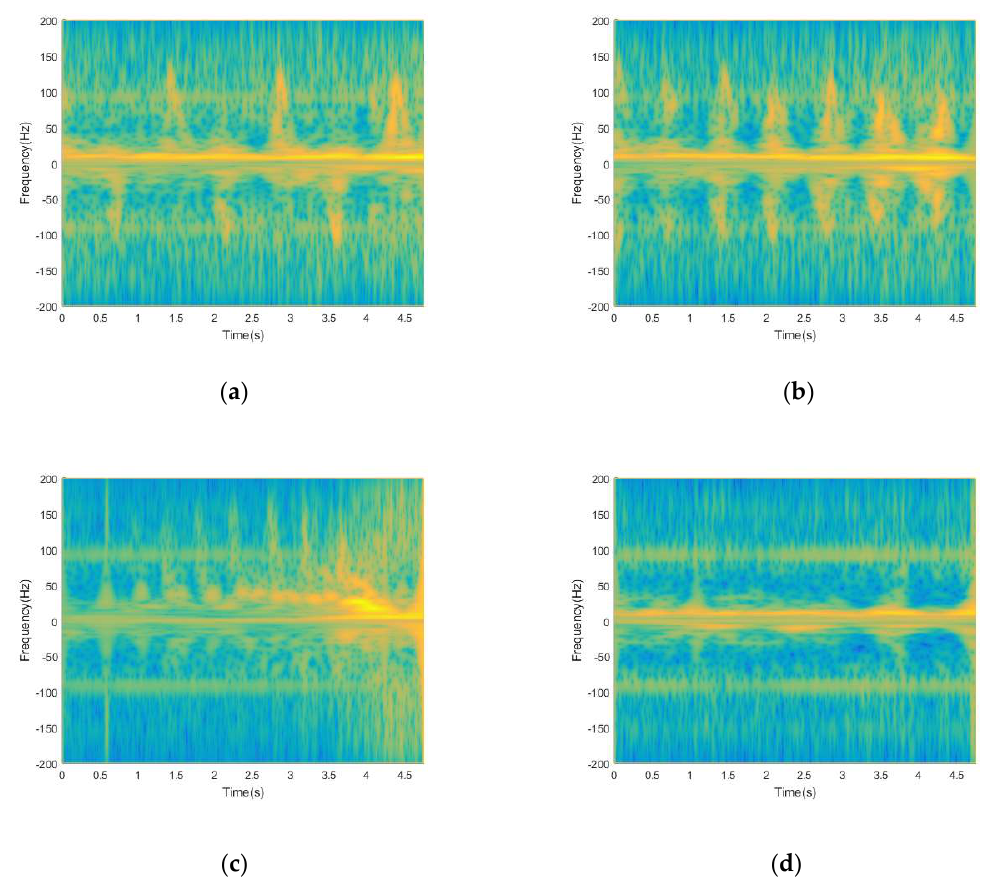
Figure 10. ( a ) Time-frequency distribution of walking with one arm swinging. ( b ) Time-frequency distribution of walking with both arms swinging; ( c ) Time-frequency distribution of running. ( d ) Time-frequency distribution of walking without either arm swinging.